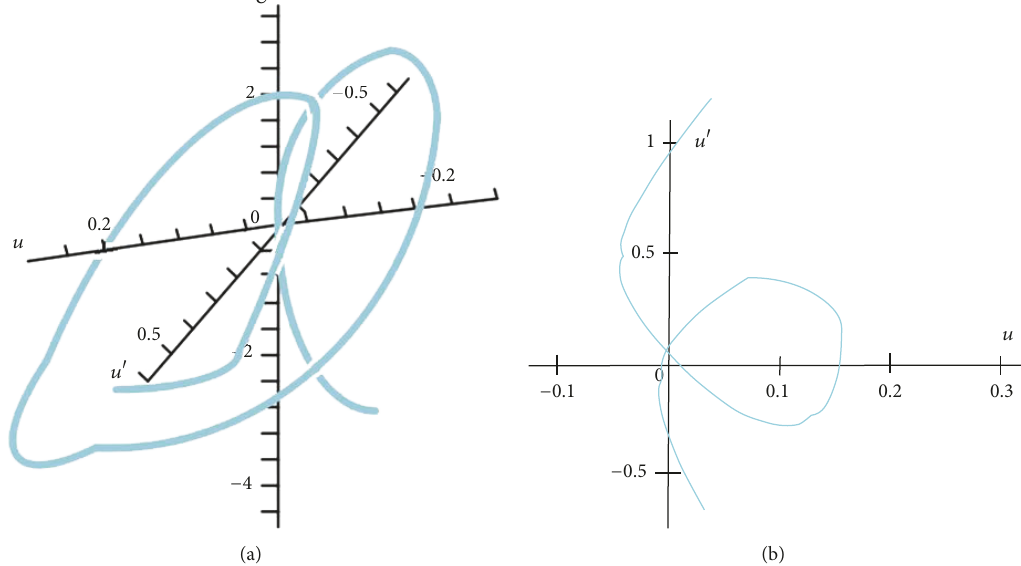
Figure 2: Numerical plot in the phase-space (𝑢,𝑢 𝜂 ,𝑢 𝜂𝜂 ) for the model KdV model (55) with no higher order perturbation term, for 𝛾 = 0.75. As expected in (a), even in the pure fractional case, the soliton solution is shown via its related homoclinic orbit to lie on a curved surface, with some irregular movements compared to Figure 1. In (b), the projection on the plane (𝑢,𝑢 𝜂 )